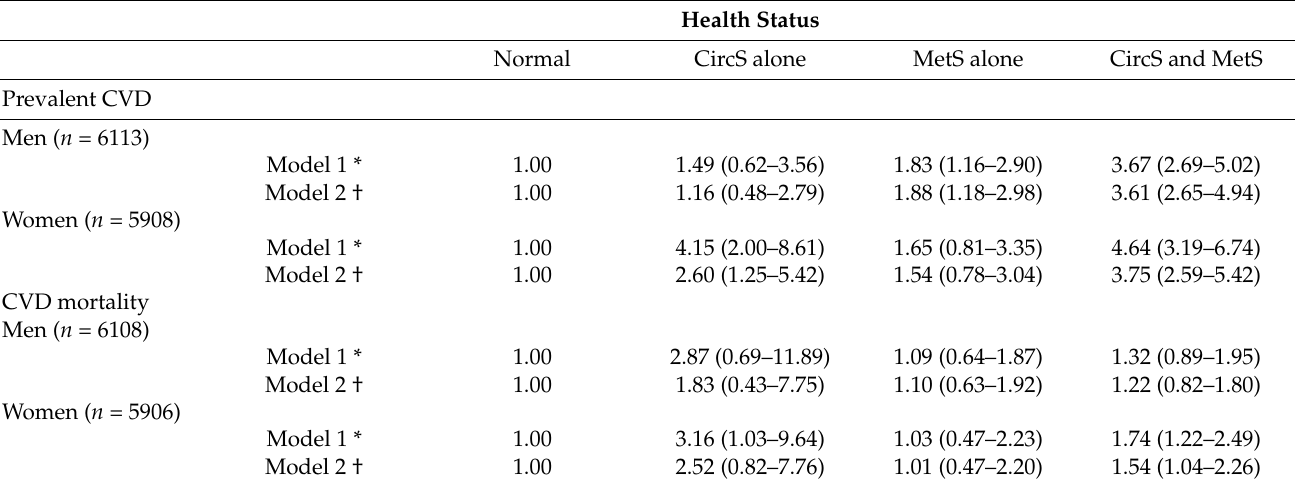
Table 4. Association between metabolic syndrome (MetS) and circadian syndrome (CircS) status and CVD among adults attending the US National Health and Nutrition Survey (NHANES 2005–2016). Health Status Normal CircS alone MetS alone CircS and MetS Prevalent